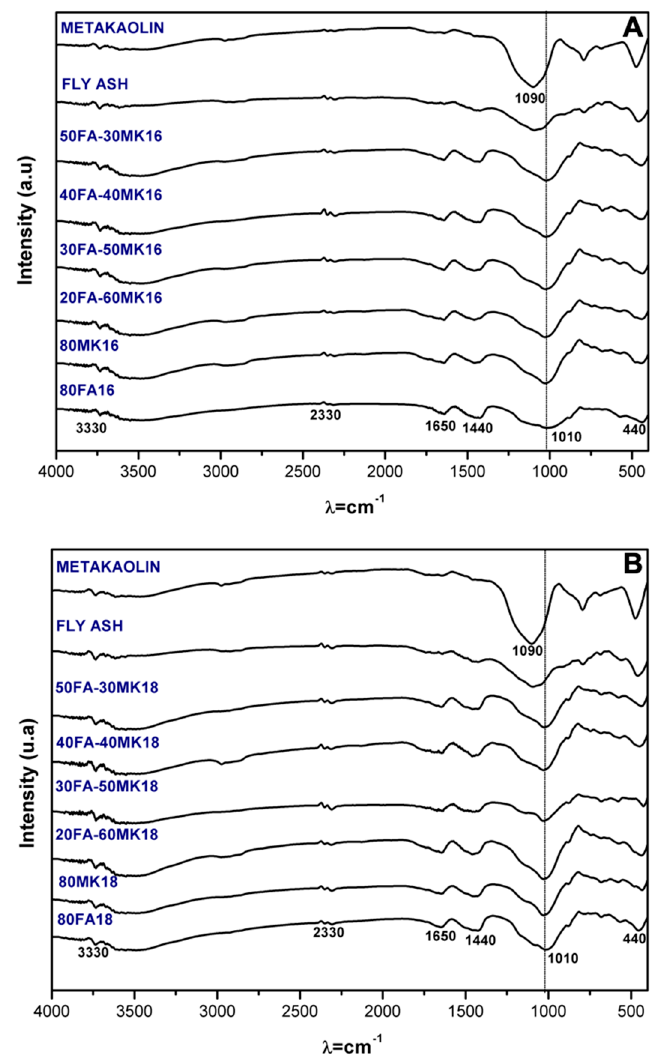
Figure 3. Fourier transform infrared spectroscopy spectra of all the systems cured at 90 days with alkaline activator with a content of ( A ) 16% Na 2 O and ( B ) 18% Na 2 O.